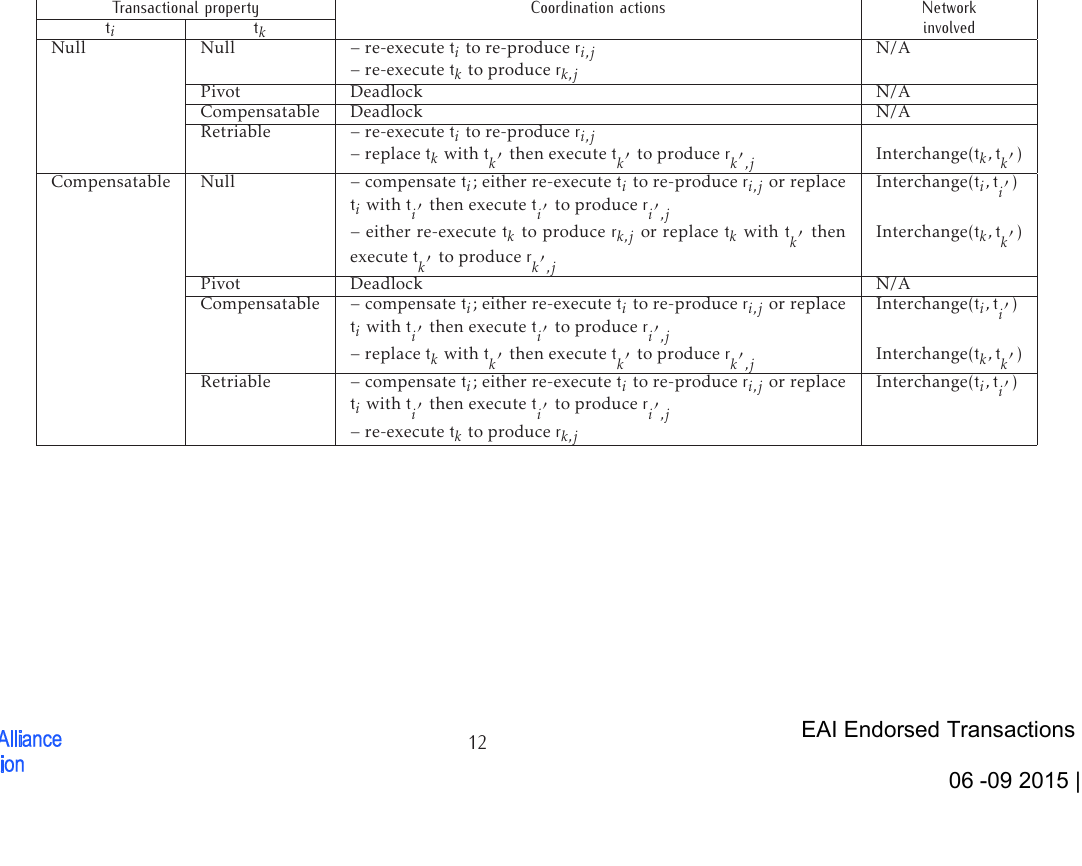
Table 4. Possible coordination actions in the case of T -Conflict